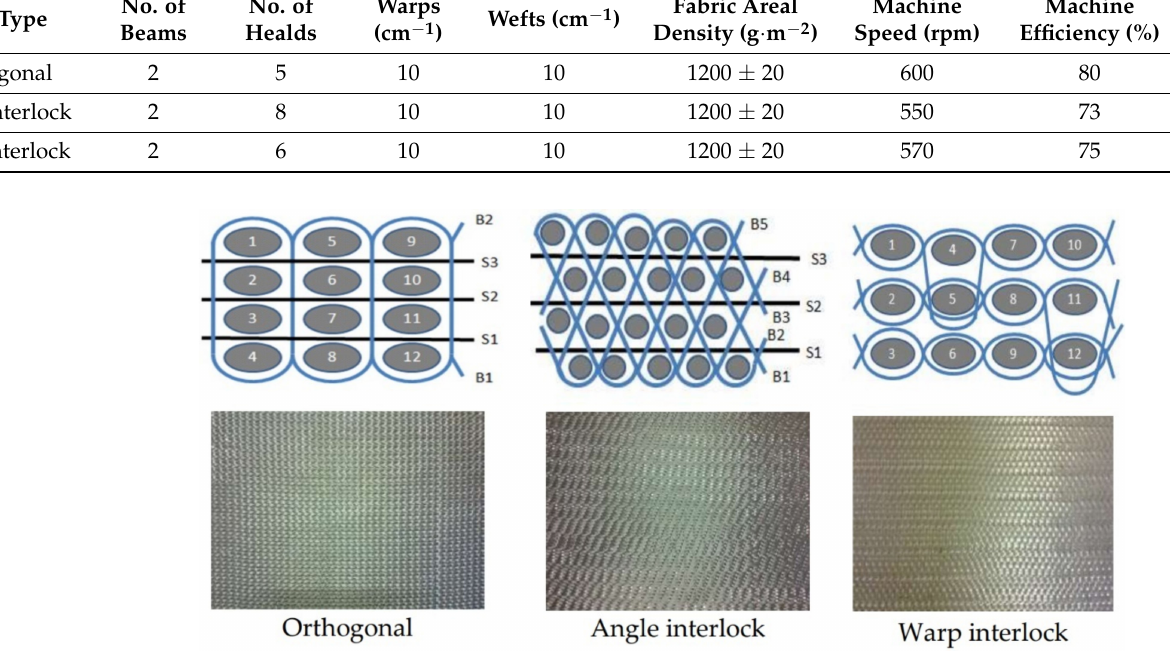
Figure 2. Schematics of the 3D woven